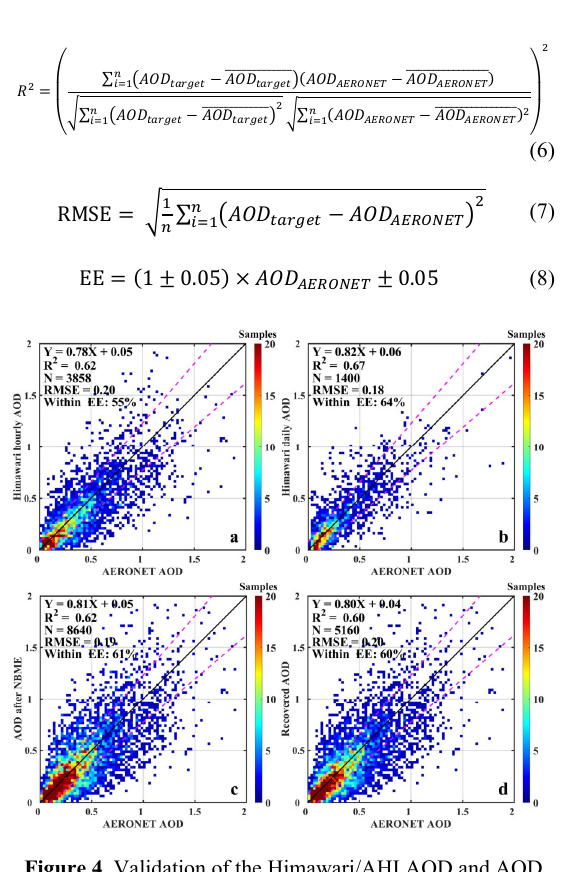
Figure 4 . Validation of the Himawari/AHI AOD and AOD after NBME against AERONET AOD. (a) Validation of the original Himawari/AHI L3 hourly AOD. (b) Validation of the original Himawari/AHI L3 daily AOD. (c) Validation of the overall AOD after recovering. (d) Validation of the recovered AOD where original Himawari/AHI AODs are missing. The purple dotted lines represent the EE envelope; the black line is the 1:1 reference line.